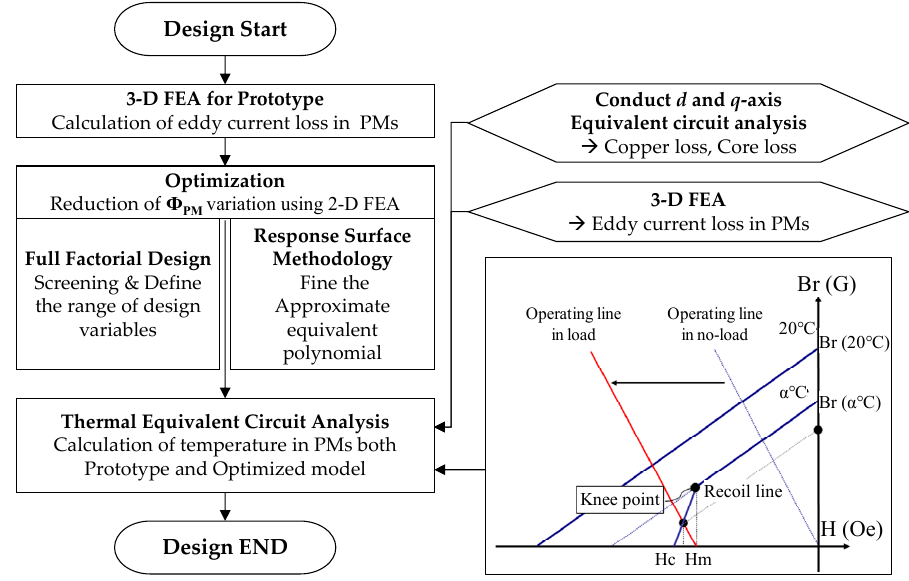
Figure 1. Overall process of the study.